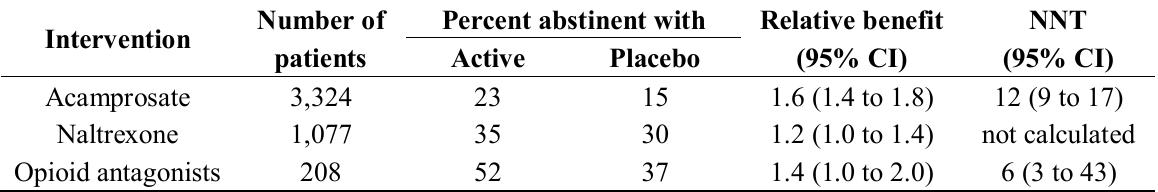
Table 4. Results of alcohol cessation reviews, ordered by number of participants. The order is by numbers of participants in the reviews. Intervention is as described in each review, and details of the reviews is in Table 1.